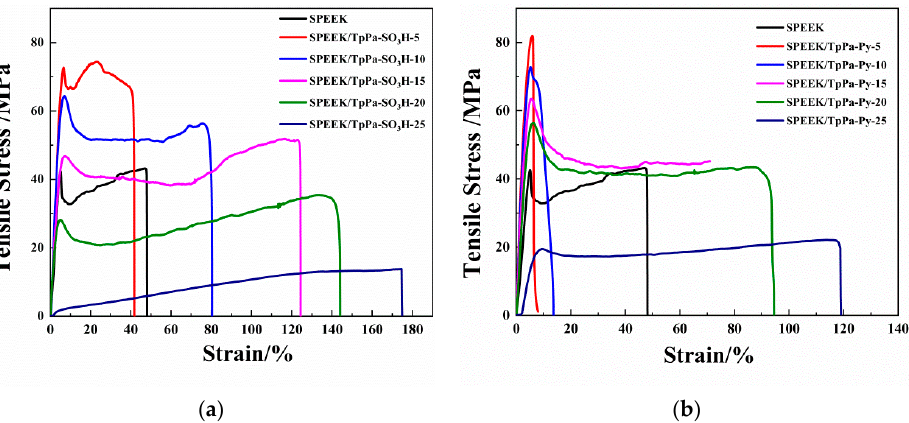
Figure 6. Stress–strain curves of ( a ) SPEEK and SPEEK/TpPa − SO 3 H, and ( b ) SPEEK and SPEEK/TpPa − Py. SPEEK/TpPa −